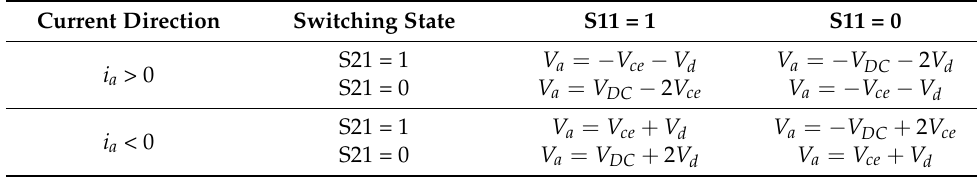
Figure 3. Schematics of inverter nonlinearity. ( a ) S11 on when i a > 0; ( b ) S11 off when i a > 0, ( c ) S21 on when i a < 0, ( d ) S21 off when i a < 0. Table 1. Actual voltage in different switching states.